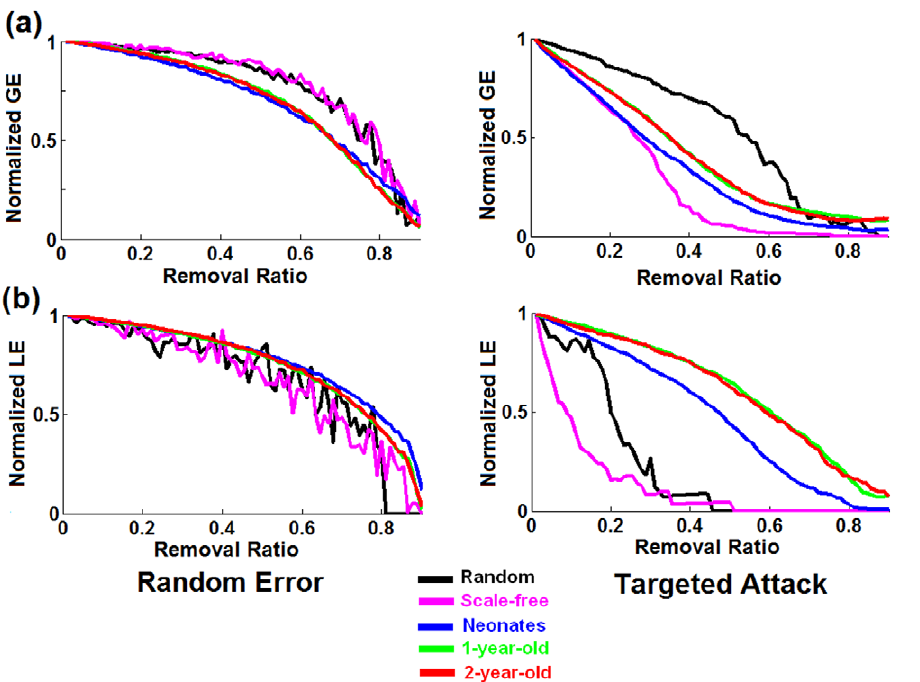
Figure 5. Brain’s resilience to random errors and targeted attacks in comparison with random and scale free networks at cost 10%. (a) Effects of random errors (left) and targeted attacks (right) on GE; (b) Effects of random errors (left) and targeted attacks (right) on LE. All efficiency values were normalized to the corresponding values of an intact network.